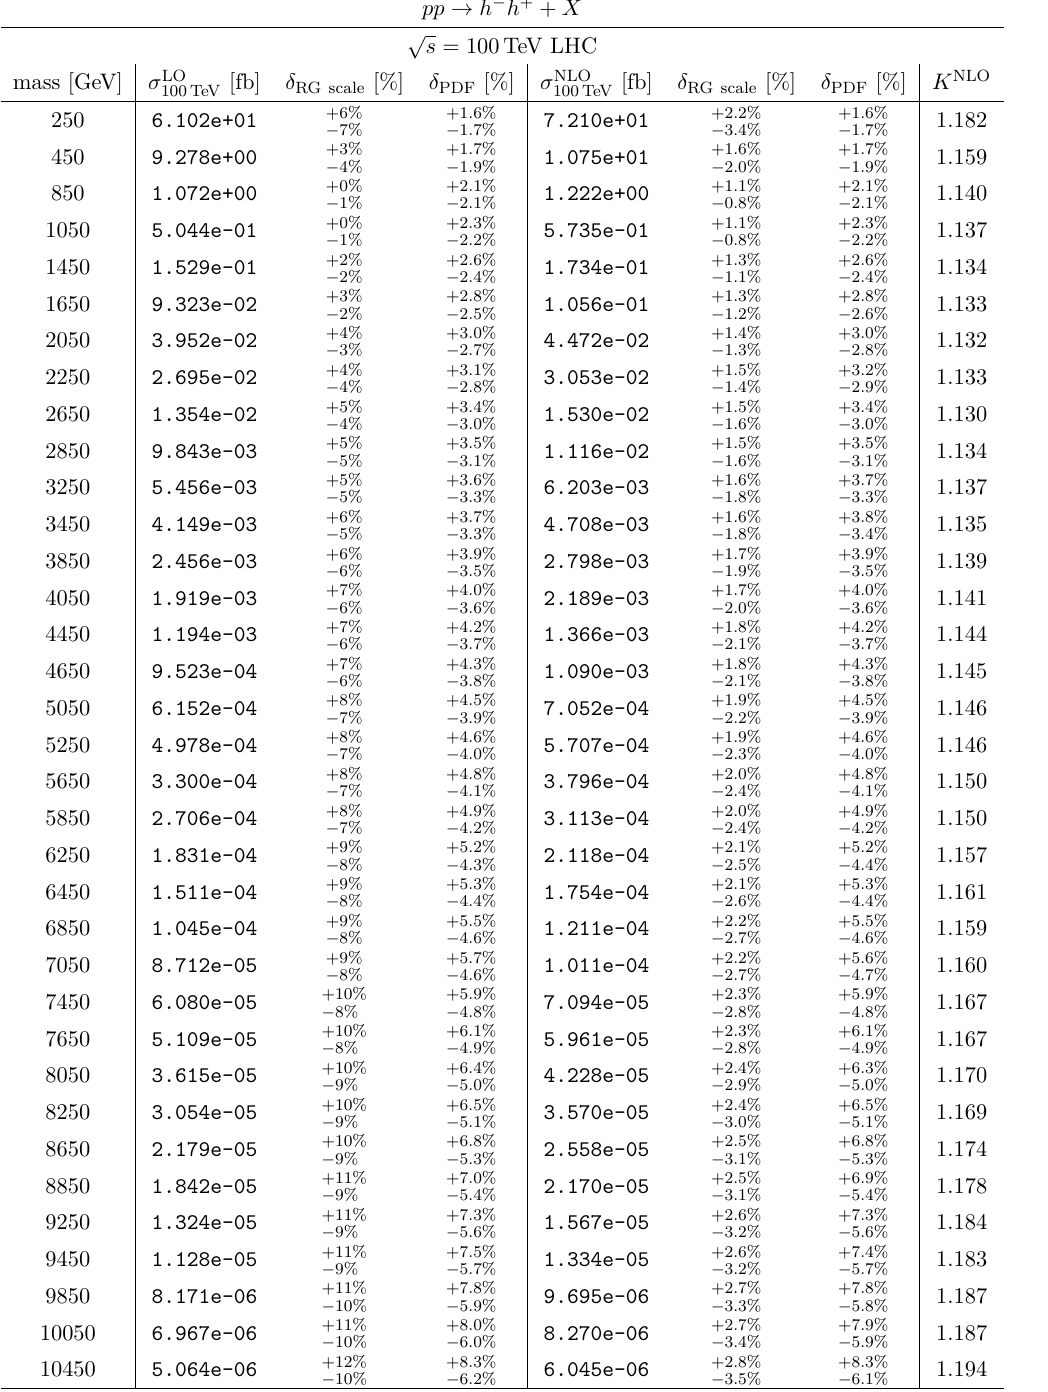
Table 11 . For representative masses m h [GeV] (first column), the predicted cross sections [fb] for √ s = 100 TeV at LO (second column) and NLO (third column) in QCD for inclusive pp → h − h + + X via the Drell-Yan process (DY). Also shown are scale uncertainties [%], PDF uncertainties [%], and the QCD K -factor. See section 3.2 for SM